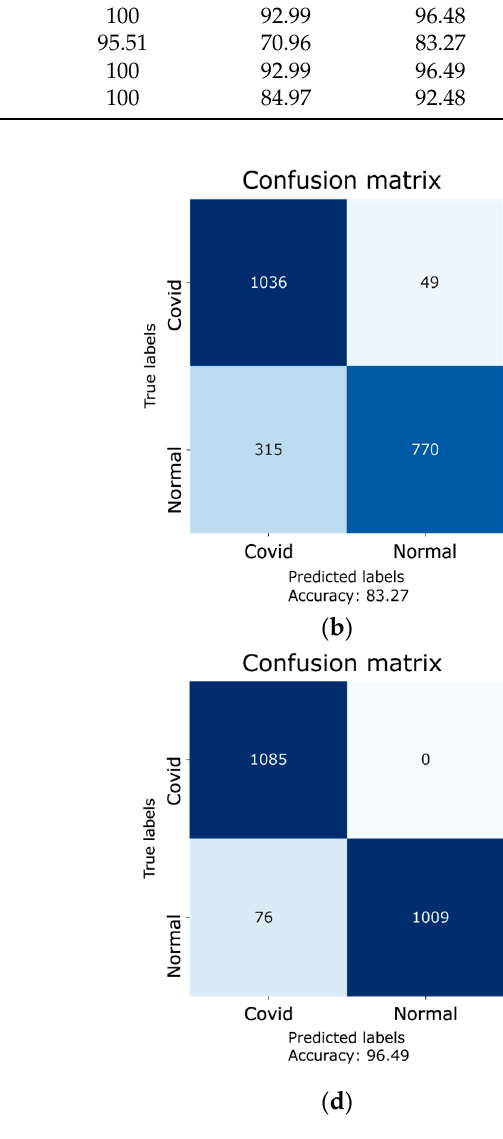
Figure 11. Confusion matrices of each model for the results on the testing dataset: ( a ) ResNet-50 model; ( b ) VGG16; ( c ) MobileNet; ( d ) DenseNet-121. Table 6. Confusion matrix of models with accuracies and 95% confidence